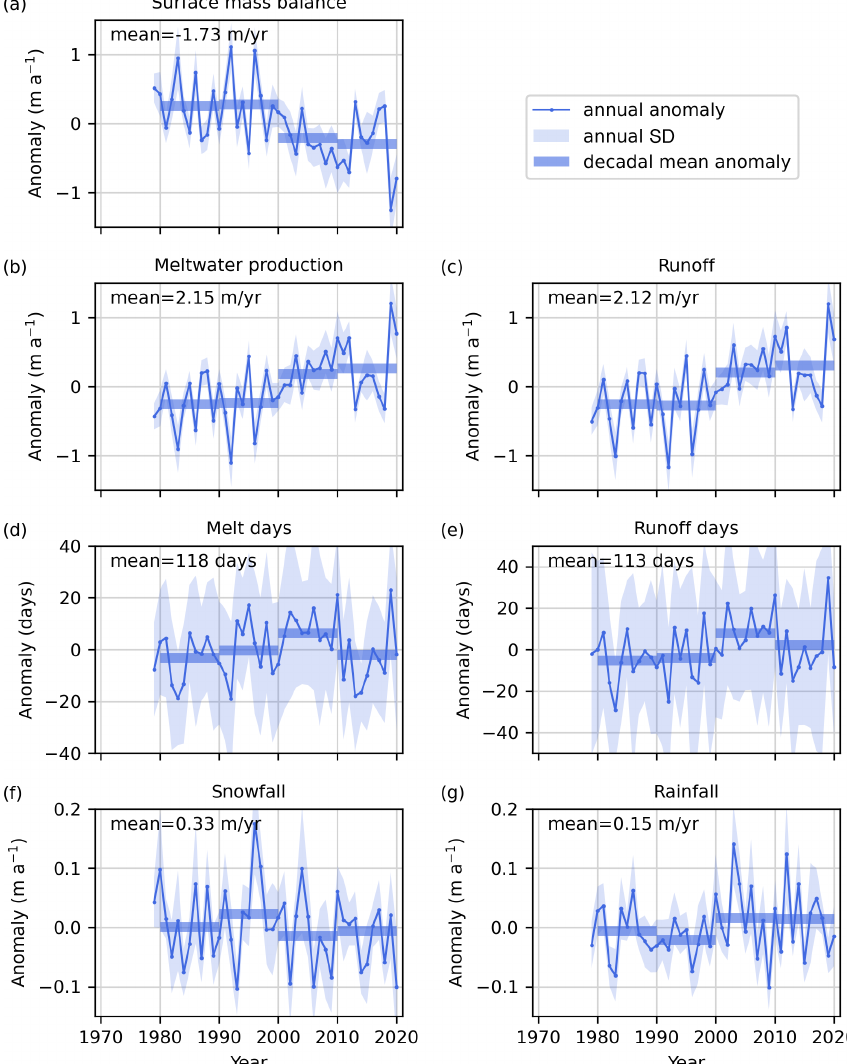
Figure 6. Annual and decadal mean anomaly of (a) surface mass balance, (b) meltwater production, (c) number of melt days, (d) runoff, (e) number of runoff days, (f) snowfall, and (g) rainfall, from the MAR climate model, averaged over all glacier fronts in the study area. The mean for each anomaly is reported in each